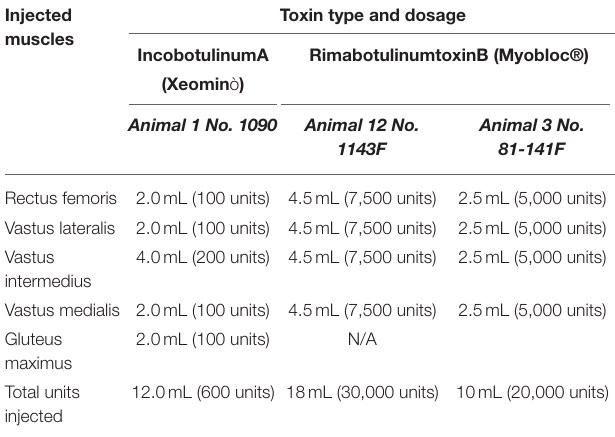
TABLE 1 | Injected muscles, toxin type and